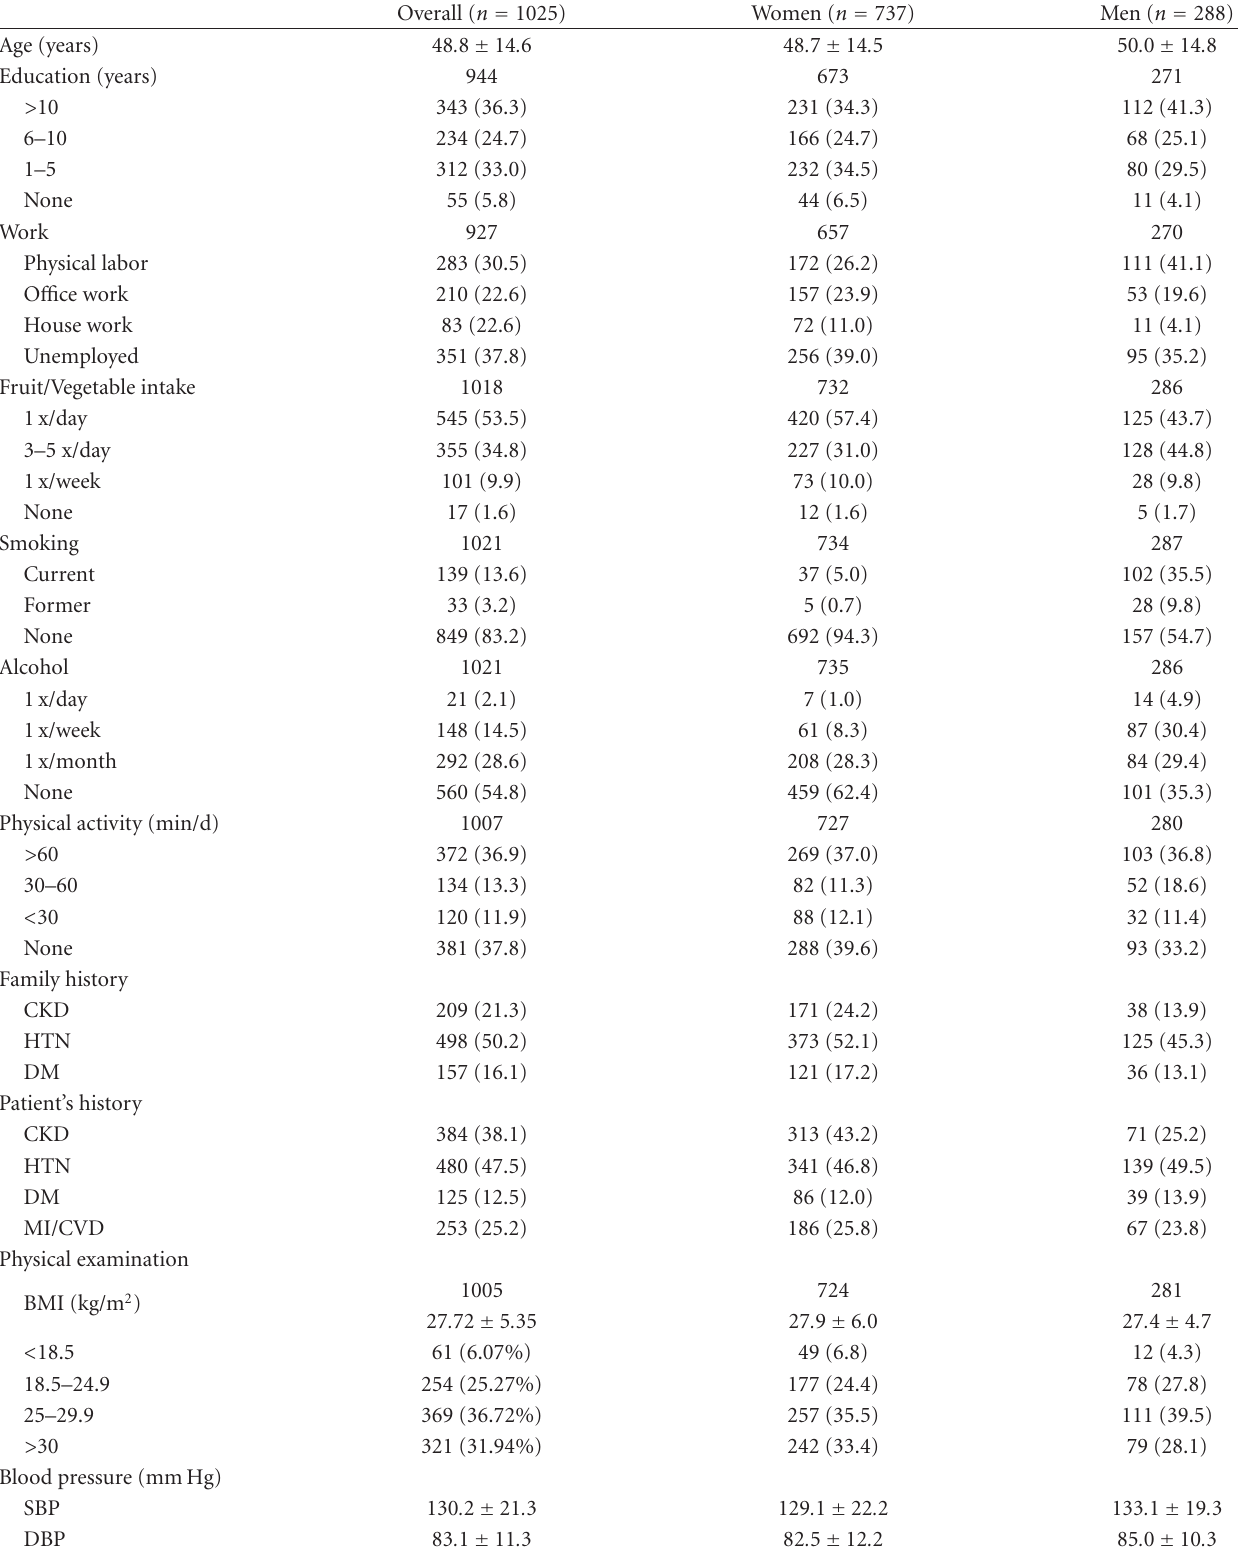
Table 1: Demographics and clinical characteristics of participants in the screening